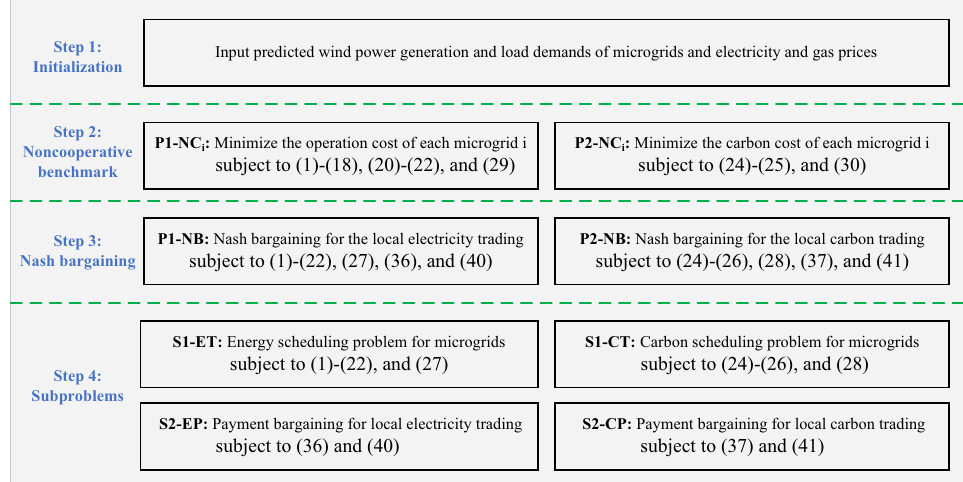
Figure 3. Implementations of the local electricity and carbon